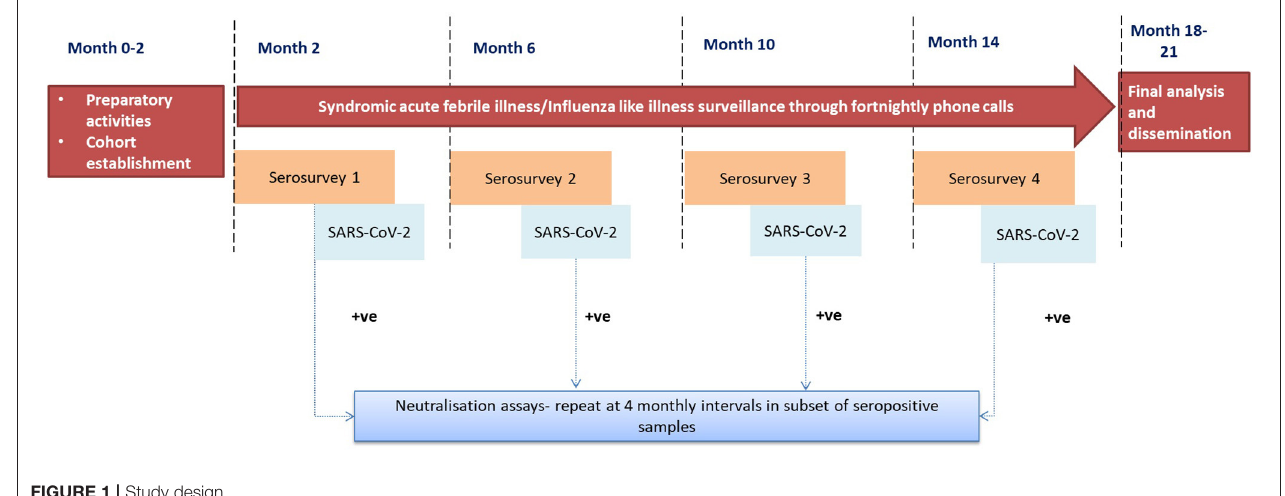
FIGURE 1 | Study design.